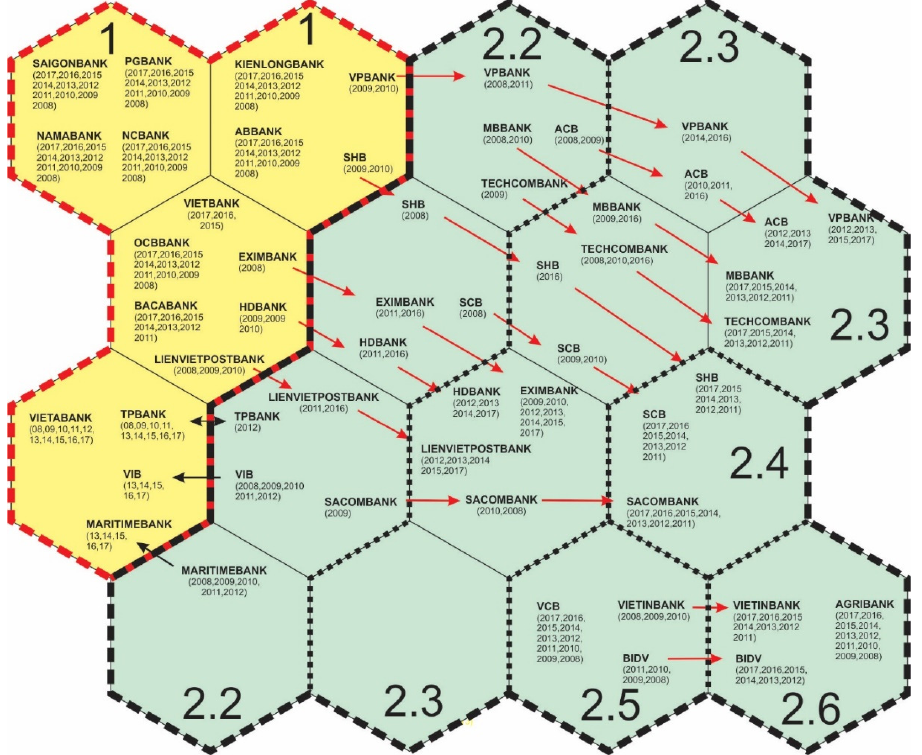
Figure 2. Final trajectory patterns of Vietnam banks for the period 2008 to 2017. Note: ‘1’ = super-class group 1 bank; ‘2’ = super-class group 2 bank; 2.2 to 2.6 = groups 2 to 6 are classified as super-class group 2 banks. Source: author’s computa- tion. Table 1. Bank group one and two results for the sampled banks for the period 2008 to 2017.